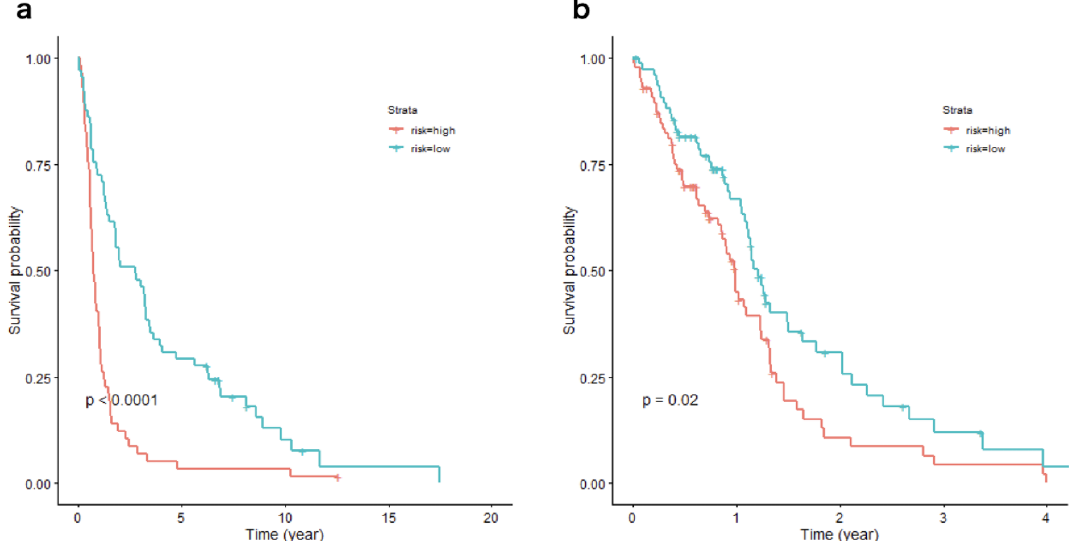
Figure 5. Overall Kaplan–Meier curves of high risk and low risk groups in ( a ) the GSE16011 glioma patients and ( b ) the TCGA glioblastoma patients with Cox proportional hazard modeling using 7 gene expressions ( SHMT1 , SHMT2 , VPS29 , PSAT1 , SRR , PHGDH , and PSPH ) in serine and glycine biosynthesis pathway. Overall patient survival was determined in patients with high risk (log risk > 0) and low risk (log risk < 0) categorized by the Cox proportional hazard model based on expression of the 7 genes. The p-value was calculated by the log- rank test to evaluate whether two survival curves were statistically significantly